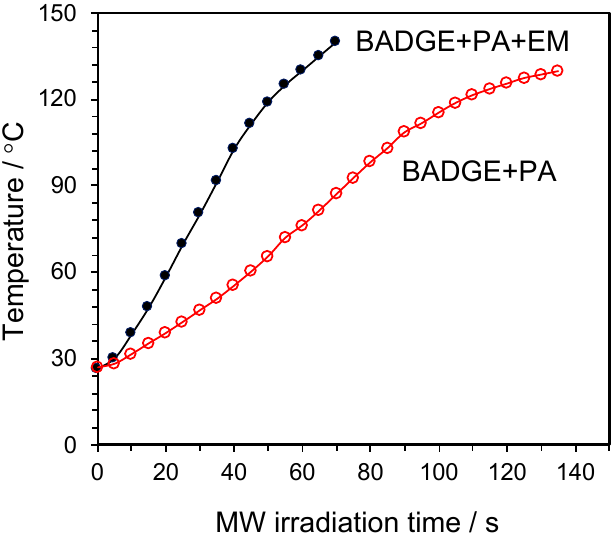
Figure 5. Temperature change due to electric field ( E -field) heating with 10 W microwaves using a single-mode applicator and a semiconductor microwave generator for the (BADGE + PA + EM) and (BADGE + PA) samples.